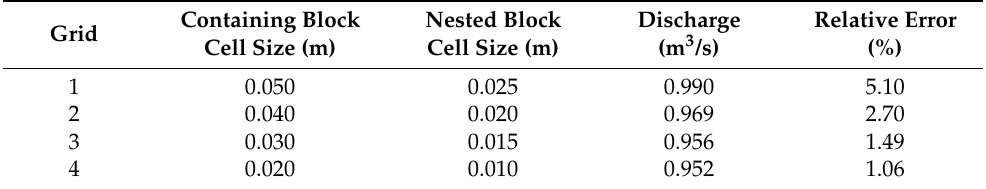
Table 2. Grid independence test.